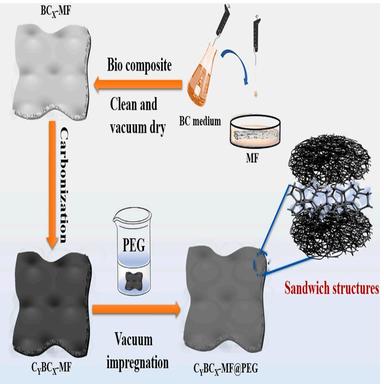
Synthesis diagrams of BCX-MF and CYBCX-MF@PEG.